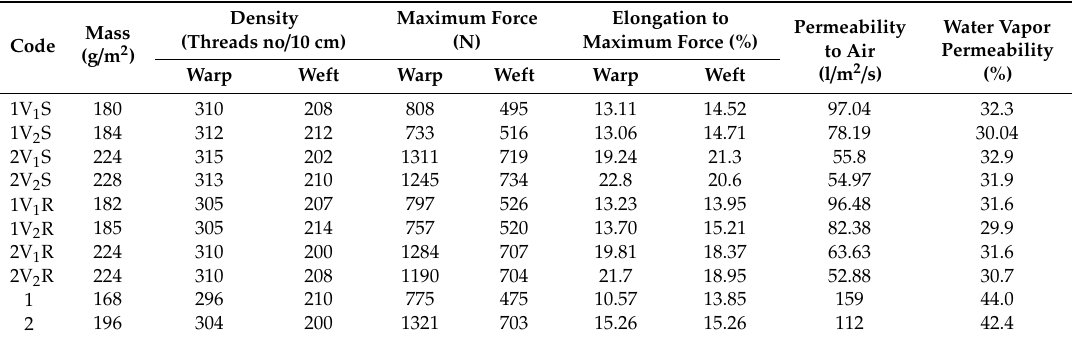
Table 2. Physical-mechanical characteristics of the treated